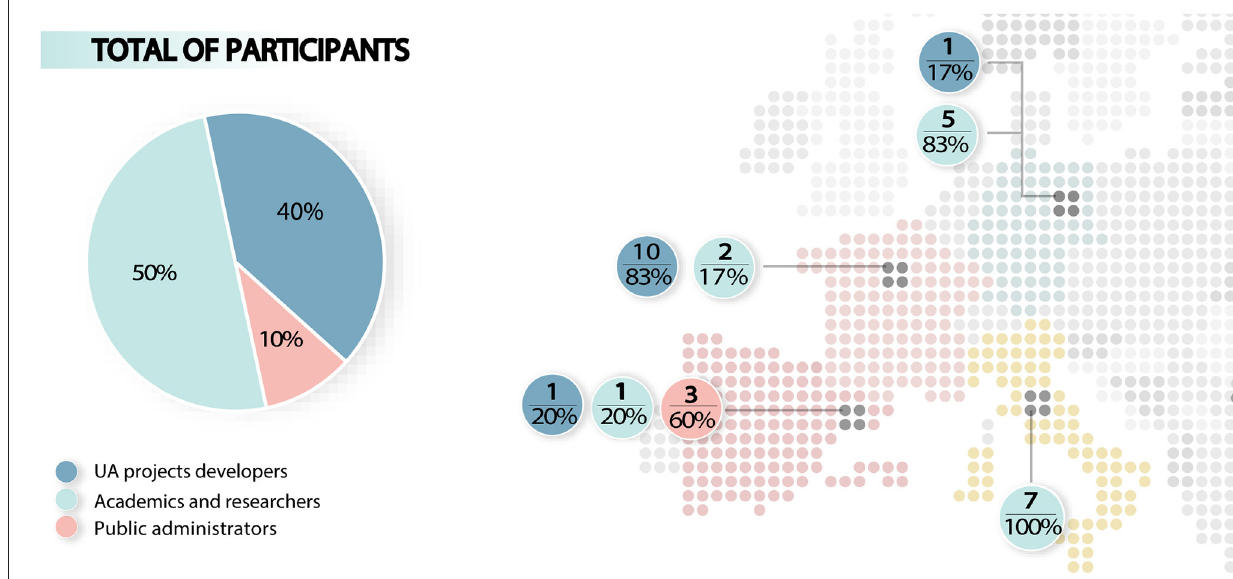
FIGURE 3 | RUA survey participants and their sectors.